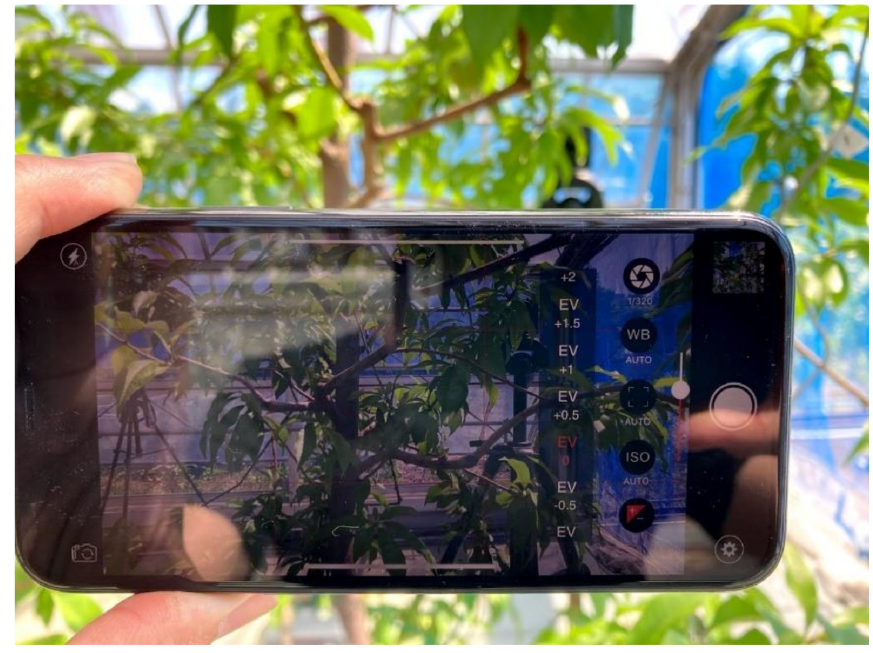
Figure 2. Image-acquisition